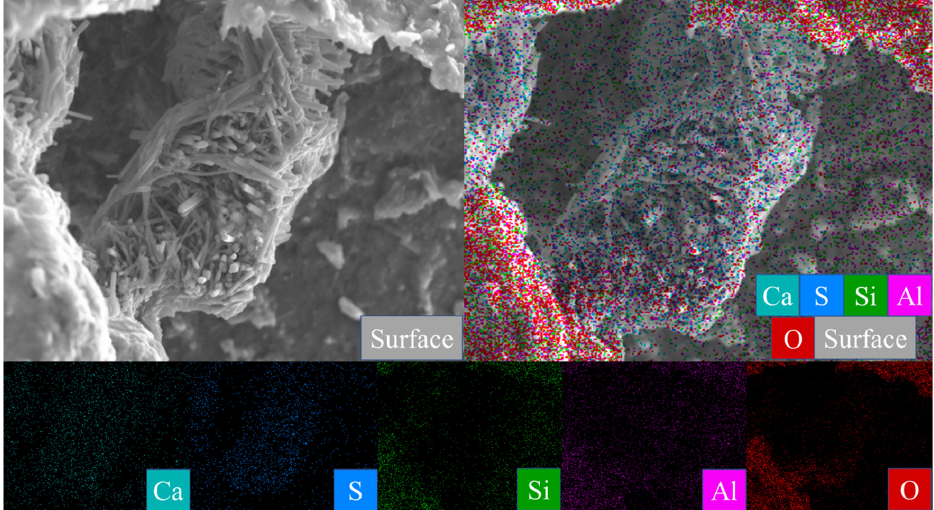
Figure 8. Scanning image of the M0-2 sample surface after 28 days of curing.